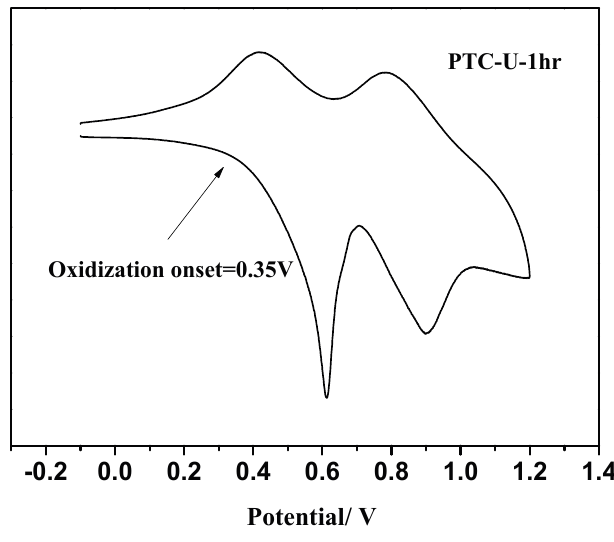
Figure 2. Electrochemical characteristic of PTC-U-1hr.